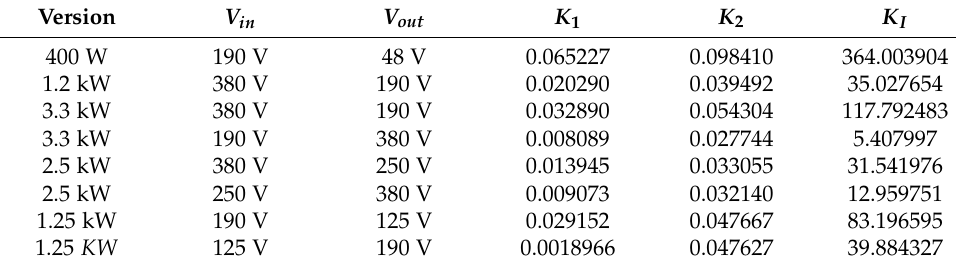
Table 9. Gain values for all the vesions of DC–DC full bridge bridge converter.